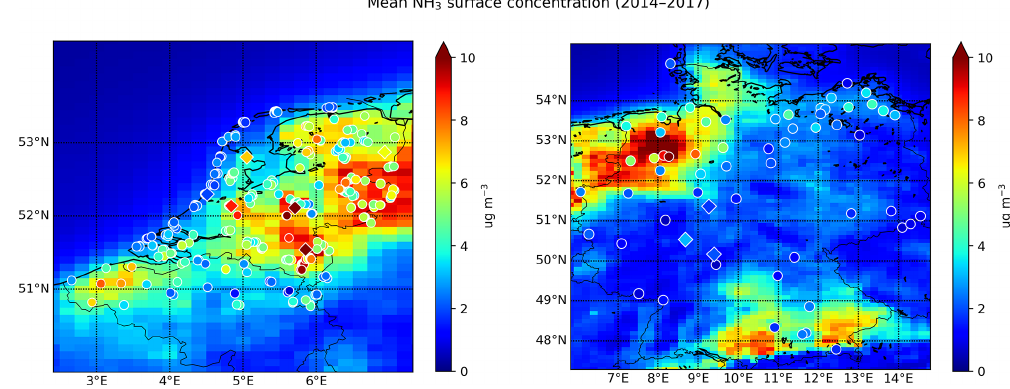
Figure 1. Locations of stations that measure NH 3 surface concentrations. The circles depict passive samplers and the diamonds hourly observations